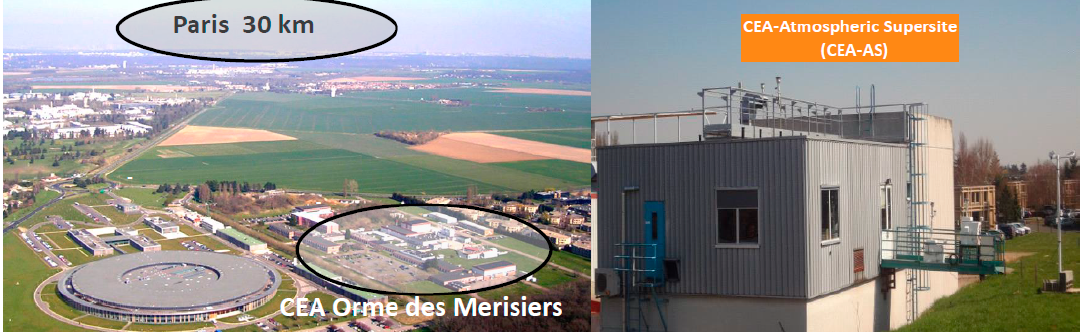
Figure 1. The geographic location of the Saclay EU-ACTRIS Observatory.